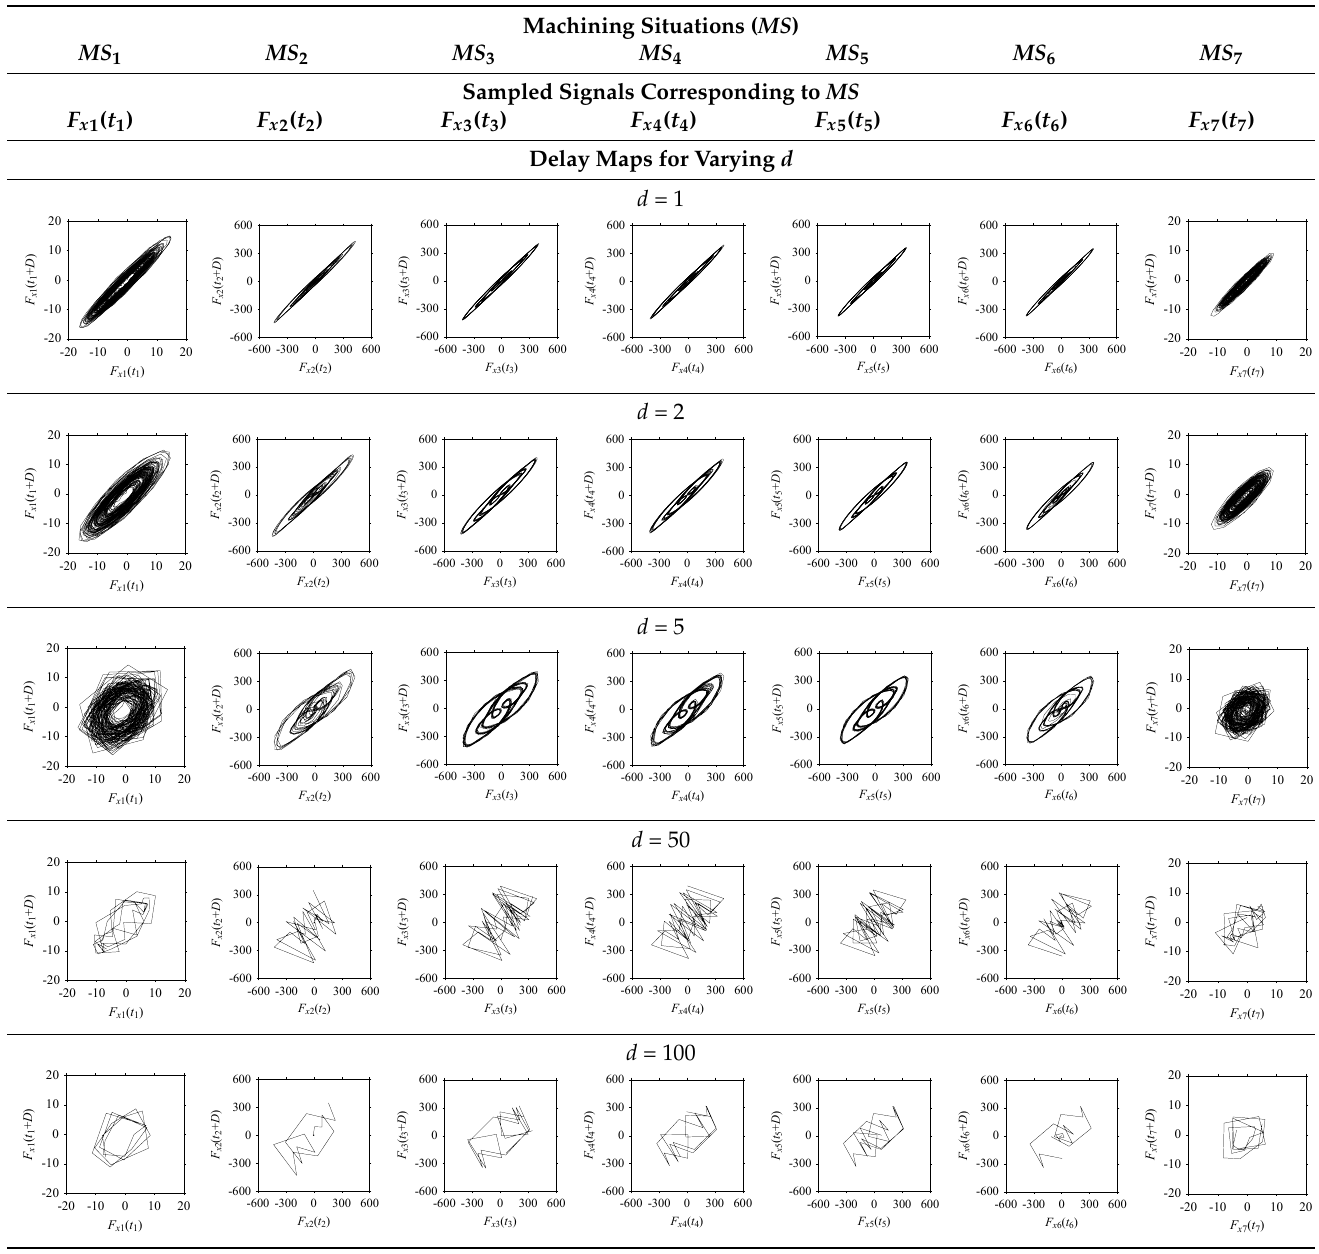
Table 6. Delay maps for F x 1 ( t 1 ),…, F x 7 ( t 7 ) (corresponds to MS 1 ,…, MS 7 ) when d = 43. Machining Situations ( MS ) MS 1